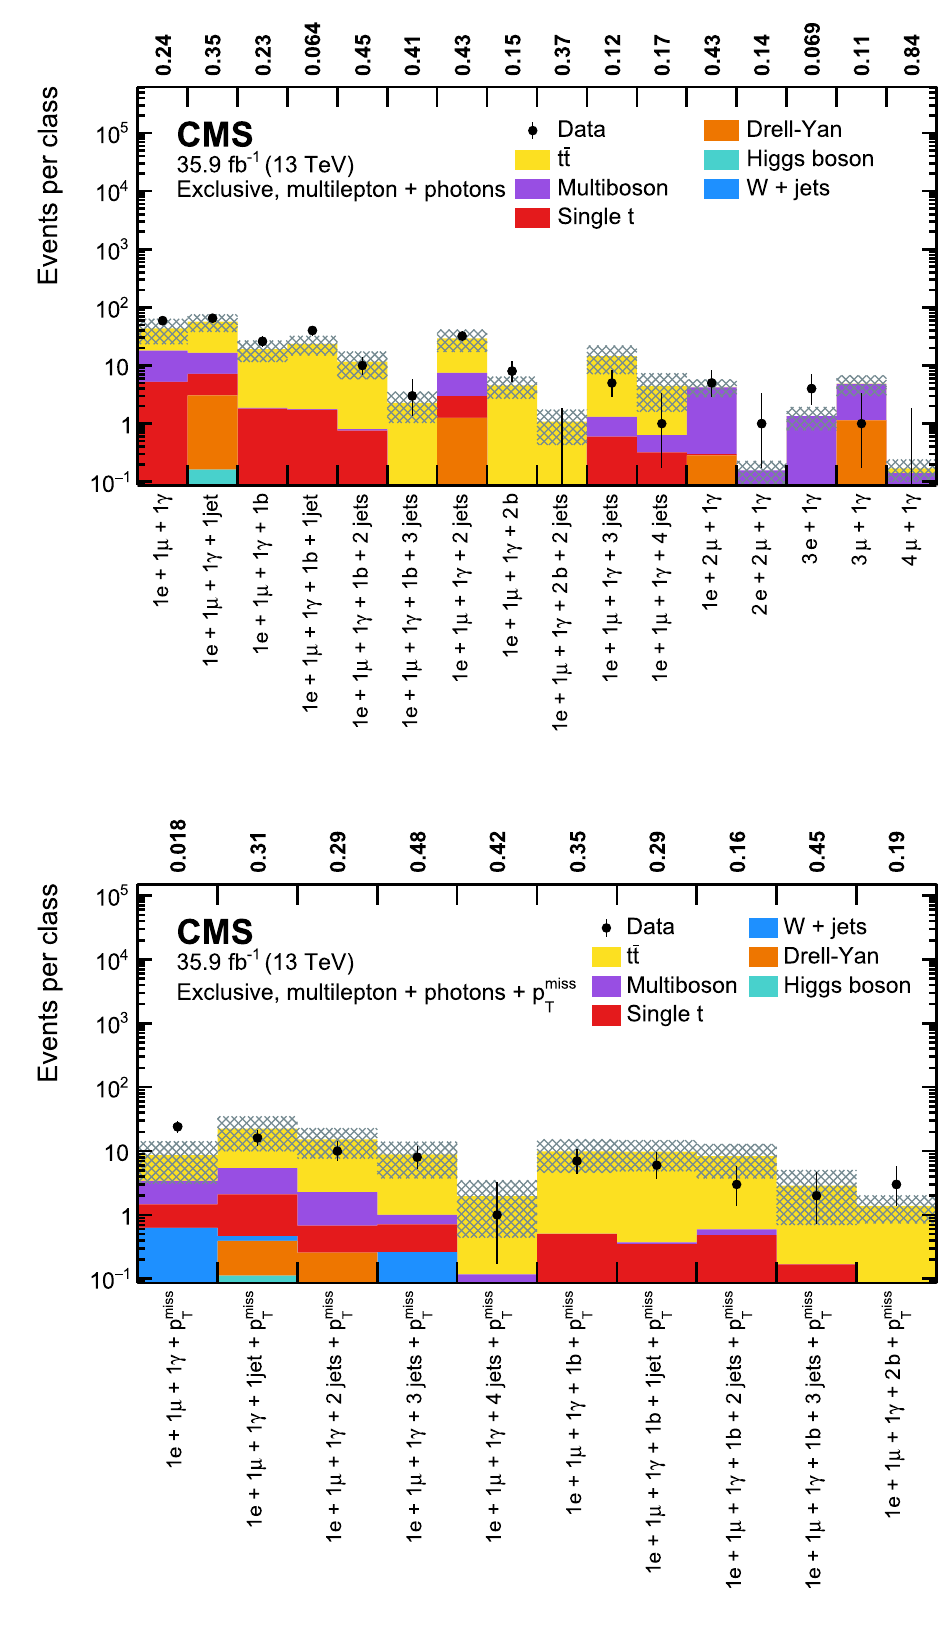
Fig. 23 Overview of total event yields for the event classes of the > 1 lepton + photons object group (upper), and the electron + muon + photons + p miss T object group (lower). Measured data are shown as black markers, contributions from SM processes are represented by coloured histograms, and the shaded region represents the uncertainty in the SM background. The numbers above the plot indicate the observed p value for the agreement of data and